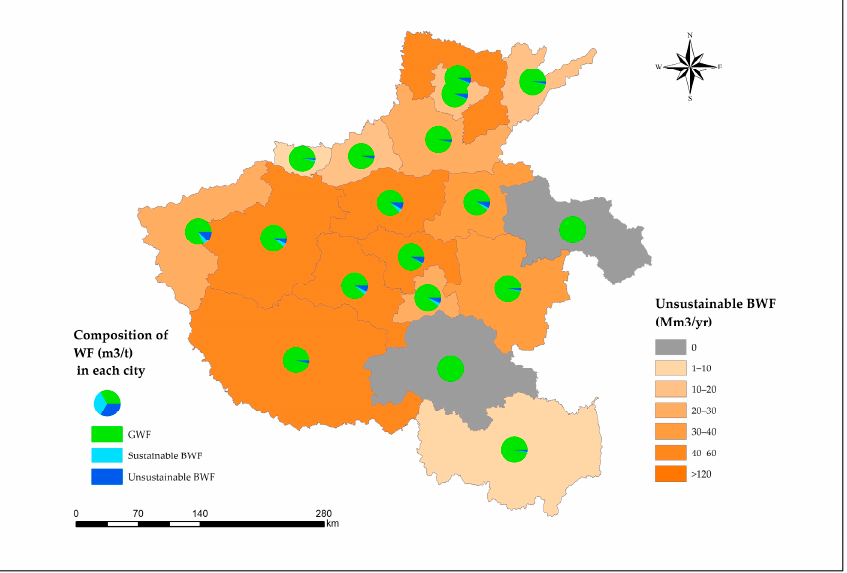
Figure 4. The distribution of unsustainable blue WF (Mm 3 /year) of maize and the composition of WF (m 3 /t) in each city.